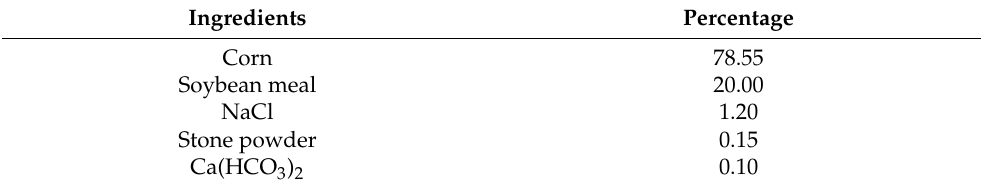
Table 1. Ingredients of concentrate supplement